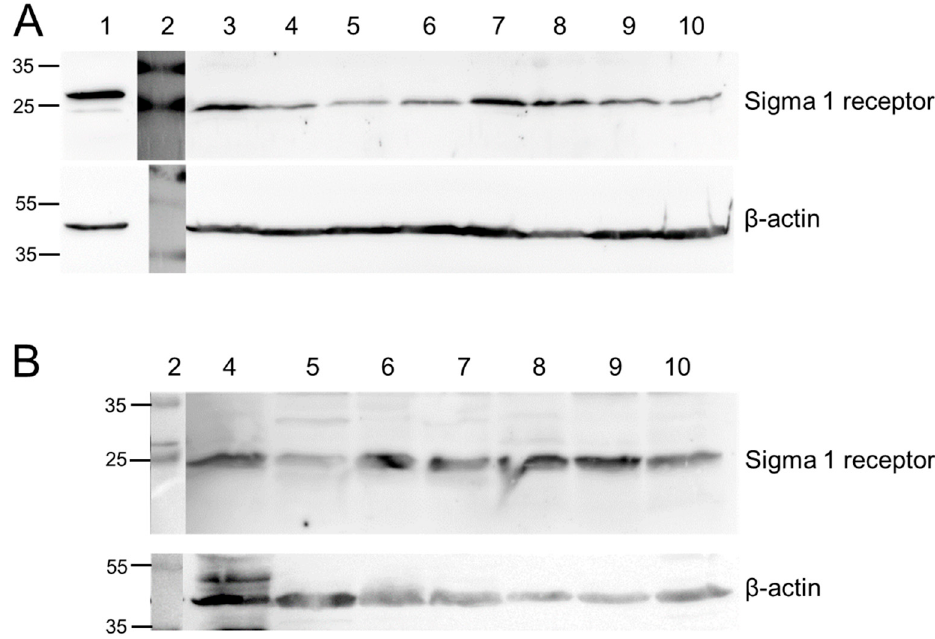
Figure 1. Detection of the Sig1R protein in ( A ) cell lysates and ( B ) tumor lysates. (1) HEK-S1R (Sig1R-overexpressing, transgenic cells, positive control), (2) protein standard, (3) HEK, (4) FaDu, (5) PC3, (6) DU145, (7) A431, (8) A375, (9) U87-MG, (10) NCI-H292. Expected band at 25 kDa. β -actin was used as loading control.